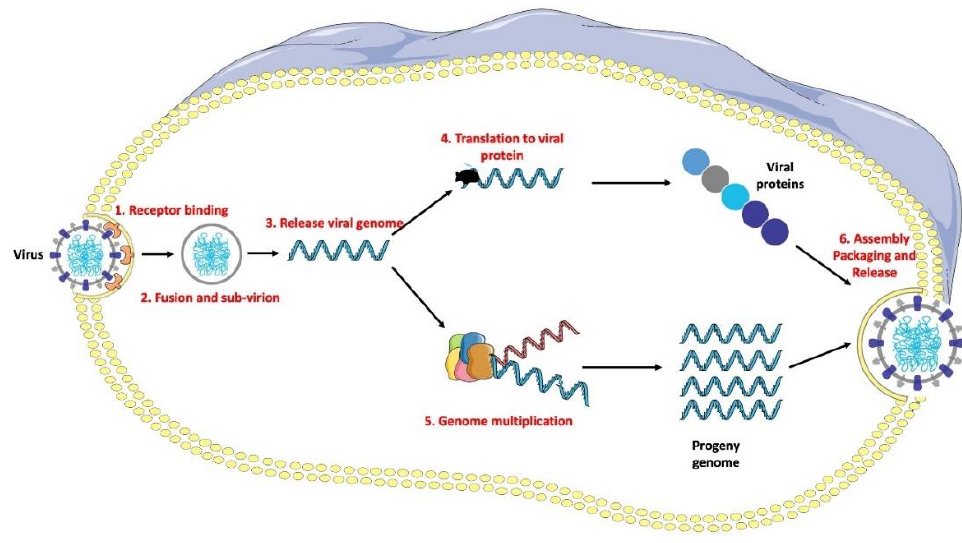
Figure 5. Main targets of antiviral drugs.